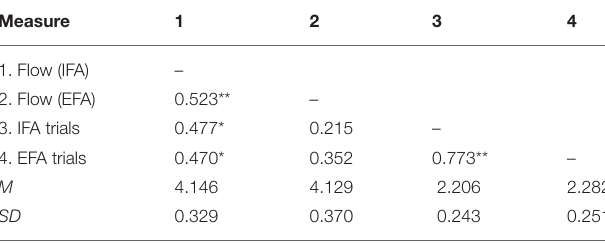
TABLE 1 | Descriptive statistics and